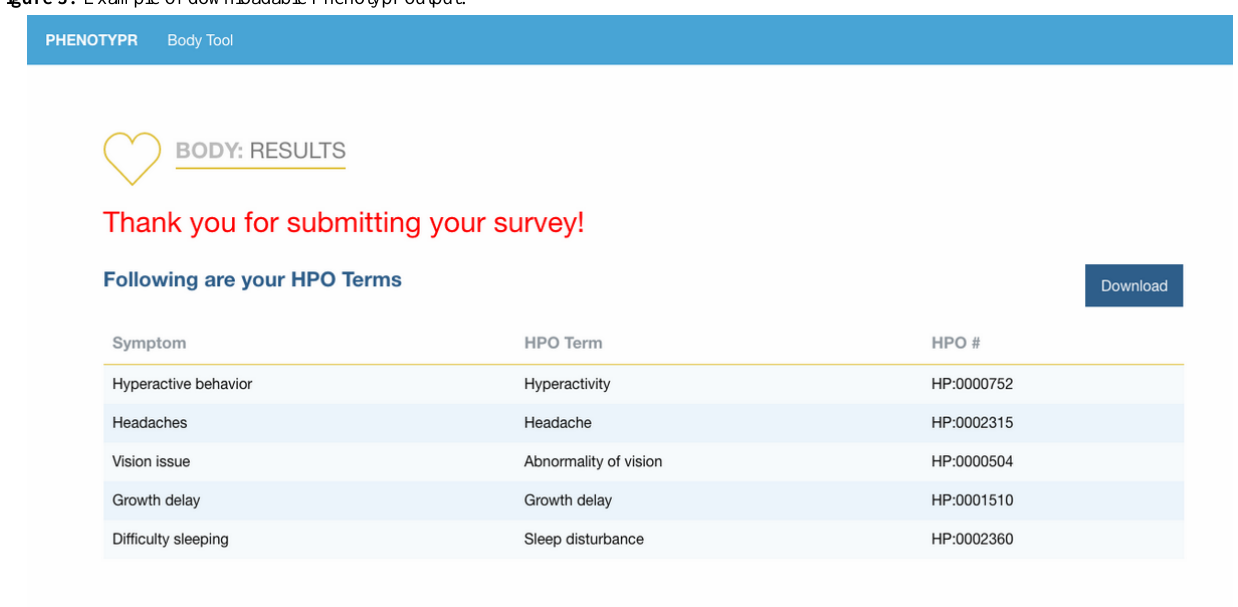
Figure 3. Example of downloadable Phenotypr